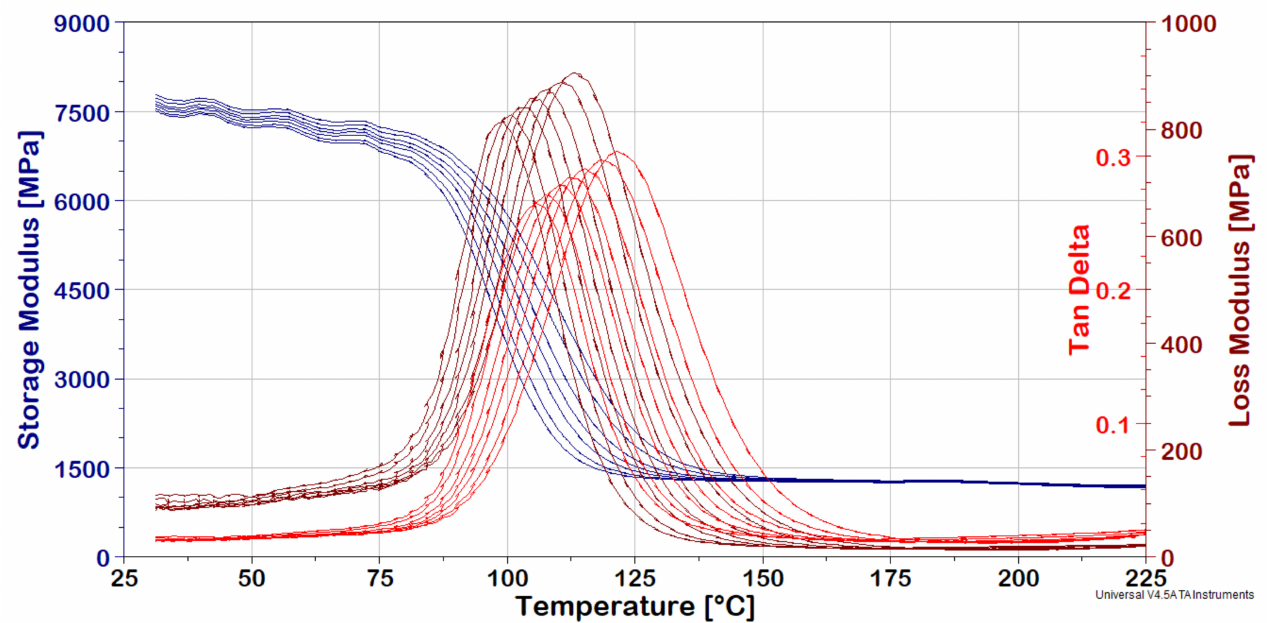
Figure 12. Kevlar/aluminum–glass composite Hybrid, DMA frequency-temperature